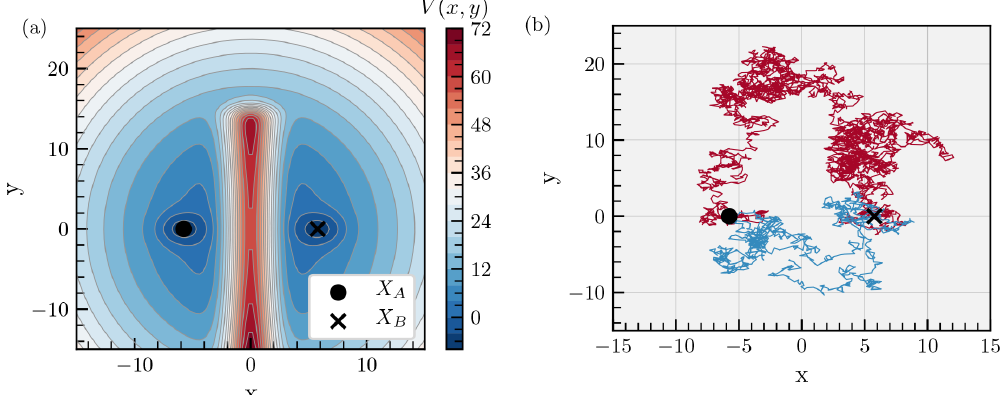
Figure 5. (a) Potential landscape of the two-dimensional gradient system defined by Eq. (15). Two energy minima are located at X A ≈ ( − 5 . 77 , 0 ) and X B ≈ ( 5 . 77 , 0 ) . They are separated by a potential barrier spanning y < 15 and at x = 0. (b) Typical transition paths from X A to X B for two noise levels σ . At high noise, trajectories can cross the potential barrier ( σ = 10, blue). At low noise, trajectories go through the upper channel ( σ = 3,